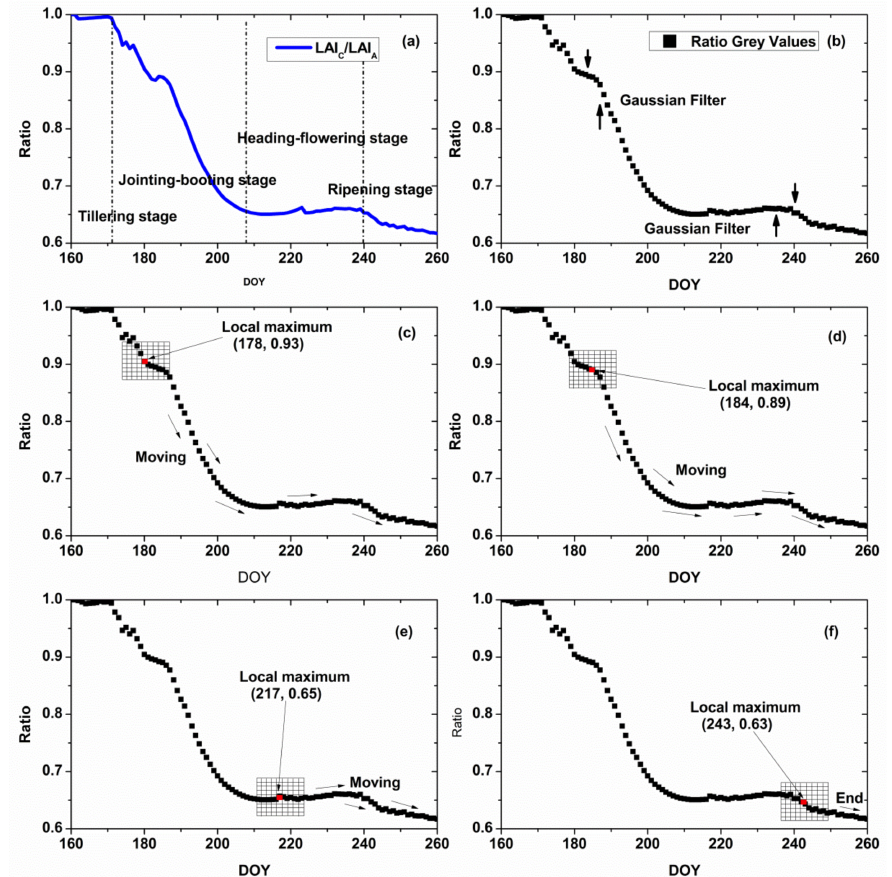
Figure 8. Process of the Harris algorithm in the ratio curve: ( a ) original ratio curve; ( b ) ratio curve with Gaussian filter; ( c – f ) process of searching for the dominant points in the ratio curve.